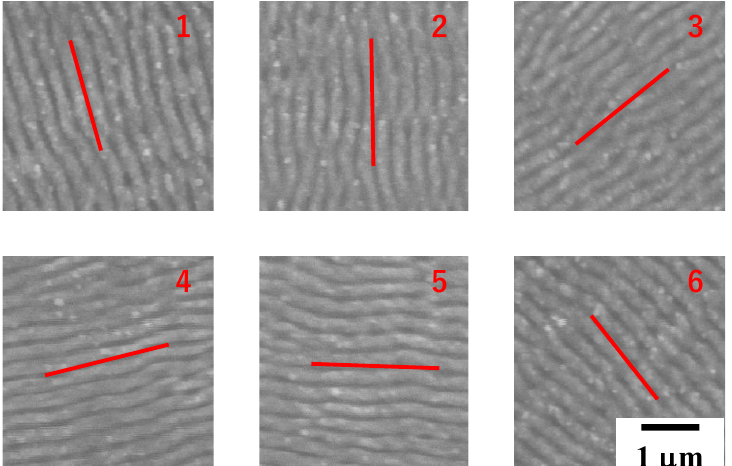
Figure 3. Six nano-textures with different orientations, from #1 to #6, formed onto the stainless steel plates by the optical path control.